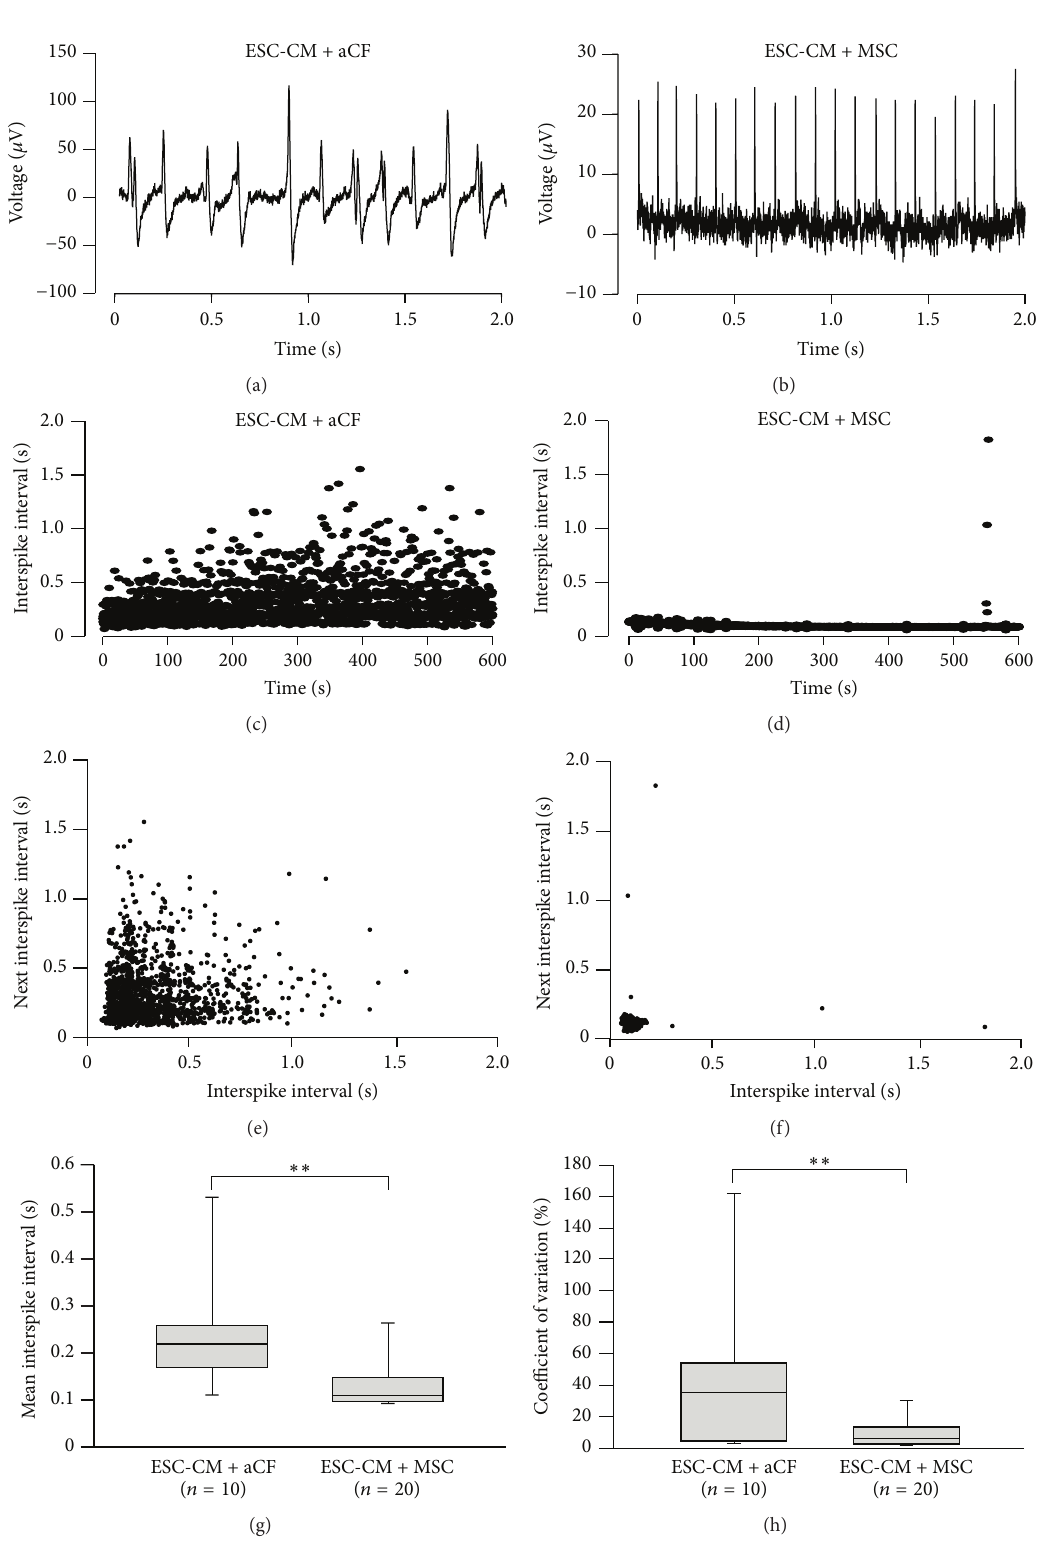
Figure 2: Effects of aCFs and MSCs on beating regularity of ESC-CMs during MEA measurements. Representative traces of aCF-ESC-CM (a) and MSC-ESC-CM (b) cocultures. ISIs of representative recordings of aCF-ESC-CM (c) and MSC-ESC-CM (d) cocultures. (e, f) Poincar´e plots of representative measurements. No propagation block patterns could be identified as a potential cause of the increased beat-to-beat variability. Mean ISI was prolonged (g) and coefficient of variation was higher (h) in aCF-ESC-CM cocultures compared to MSC-ESC-CM cocultures. Data are expressed as mean ± SEM; ∗∗ 𝑝 < 0.01